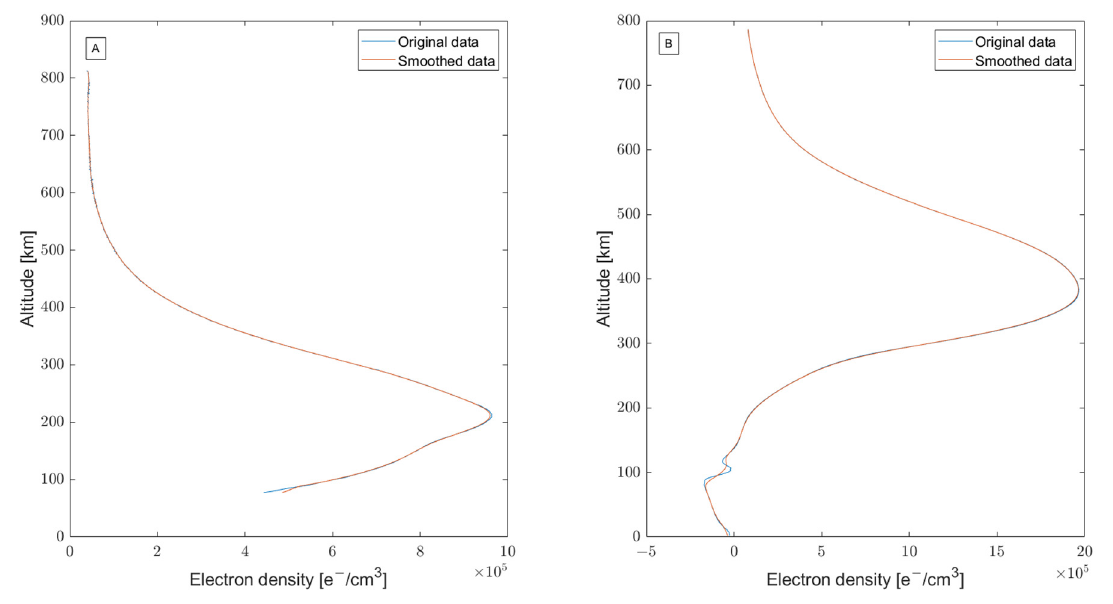
Figure 6. Examples of Formosat3 electron density profiles. Original data and smoothed data after processing is presented. ( A ) represents a standard electron density profiles while ( B ) shows a particular electron density profile with negative values and inversion of vertical profile at 100 km (ionospheric sporadic E ‐ layer).